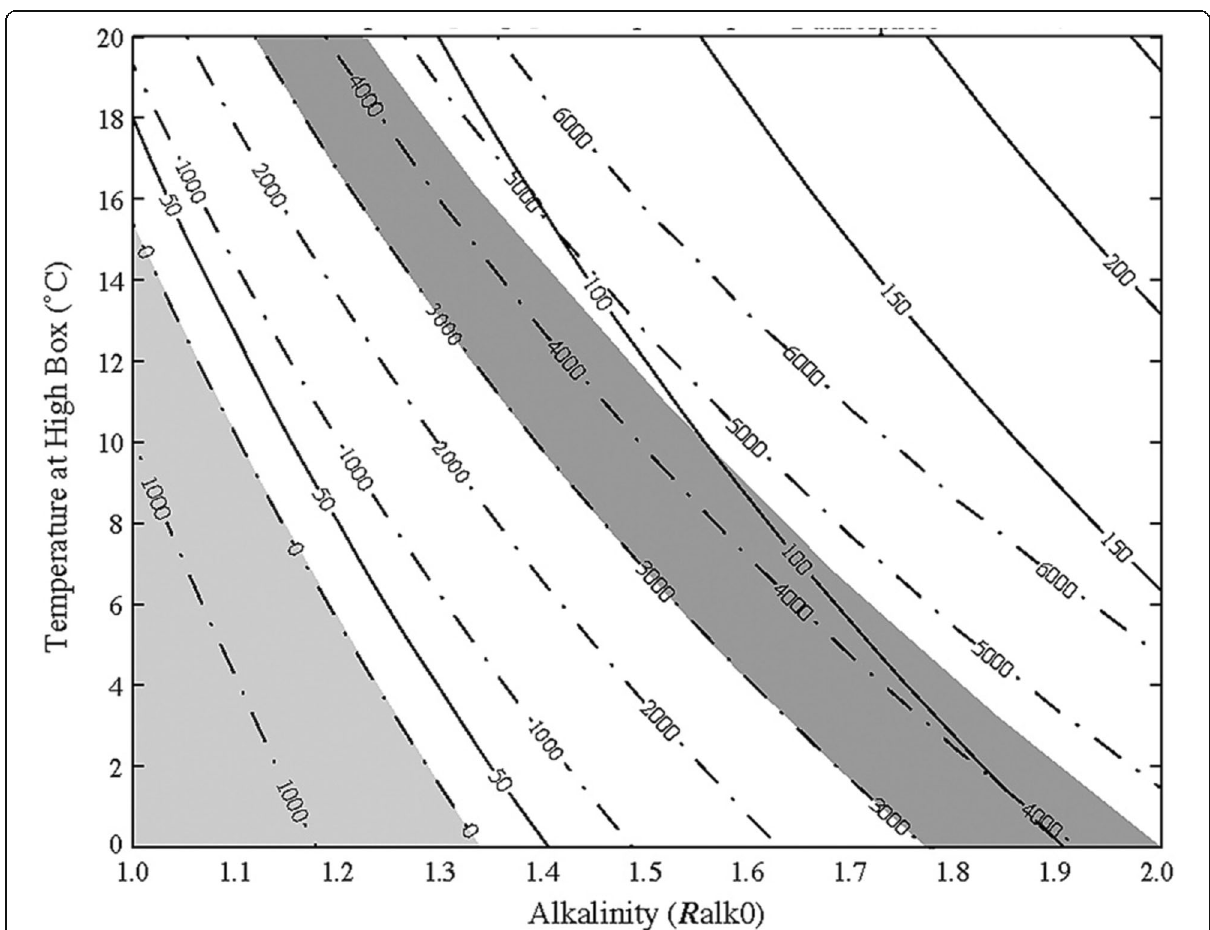
Fig. 19 Three-box model sensitivity of saturation depth and carbonate ion concentration at deep box at a high CO 2 concentration (1020 ppm) (Yamamura et al. 2007). Approximately 15% of the world ocean surface area is represented by the high-latitude box. Variable T represents the large scale meridional overturning of the world ocean. Polar vertical mixing is meant to represent deep water ventilation and formation around the Antarctic continent today. Phosphate serves as the main nutrient accounting for organic carbon production. The phosphate concentration in the low-latitude surface box drives its new production by restoring the phosphate concentration to its initial value. The production rate of organic carbon from the surface ocean is expressed as the flux of phosphate, which is assumed to occur with a stoichiometry of P: C org :-O 2 =1:117:170 (Anderson and Sarmiento 1994). In this model, the new production rate at the low-latitude surface box, which is described as P l , depends on the upwelling supply flux of phosphate due to the thermohaline circulation. In the high-latitude box, the new production rate is fixed to a prescribed value since the productivity seems to be affected by factors other than nutrients. With the production rate, we adjust the global average export ratio of CaCO 3 /C org to 0.1 based on Sarmiento et al. (2002). The solid line indicates the carbonate ion concentration ( μ mol/kg) and the broken line indicates saturation depth (m). The light-gray shading indicates the saturation depth below 0m. The dark shading indicates the range of the saturation depth, similar to the interglacial